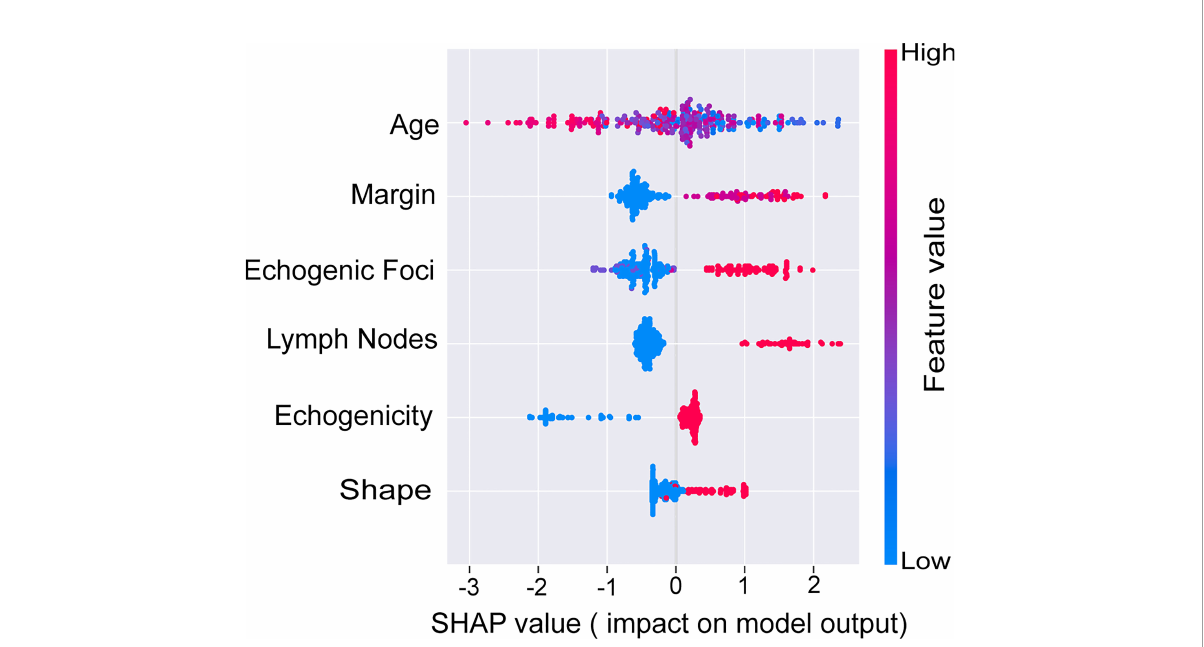
FIGURE 4 SHAP values of the selected features. The higher the SHAP value of each variable, the more impact and contribution to the model. SHAP, Shapley additive